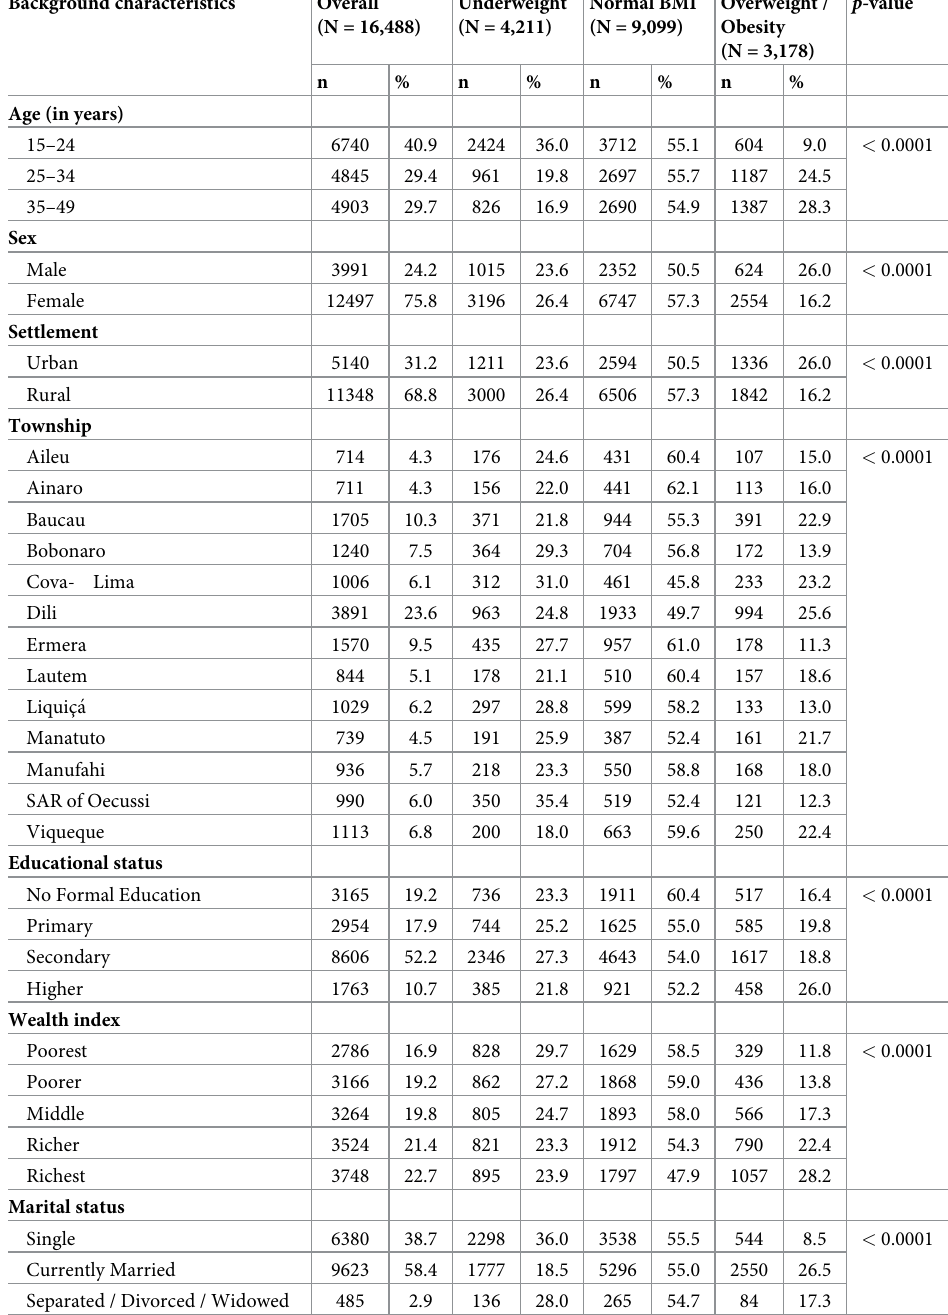
Table 1. Distribution of background characteristics of respondents according to BMI status, (N = 16,488), TLDHS 2016. Background